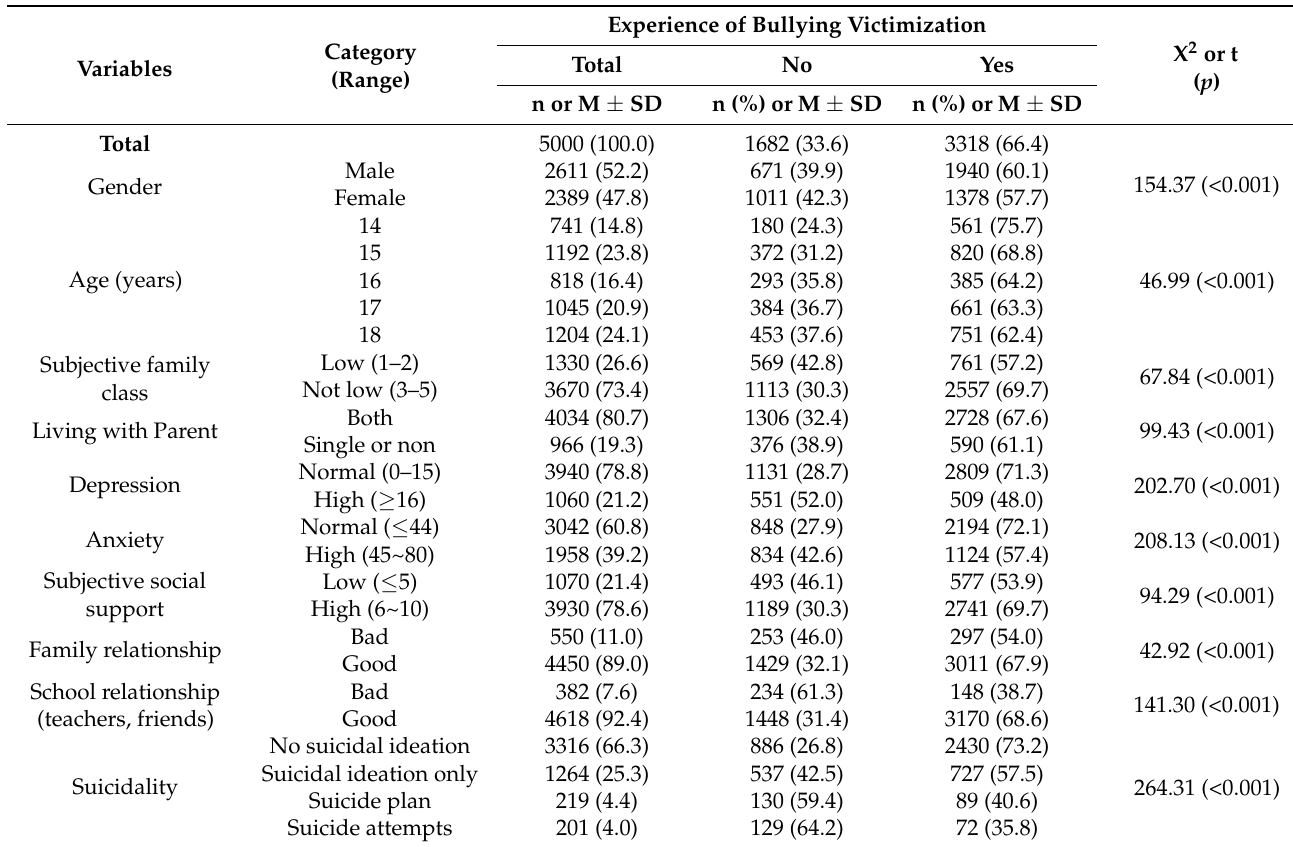
Table 1. Comparison of participants’ characteristics by experience of bullying victimization ( N =